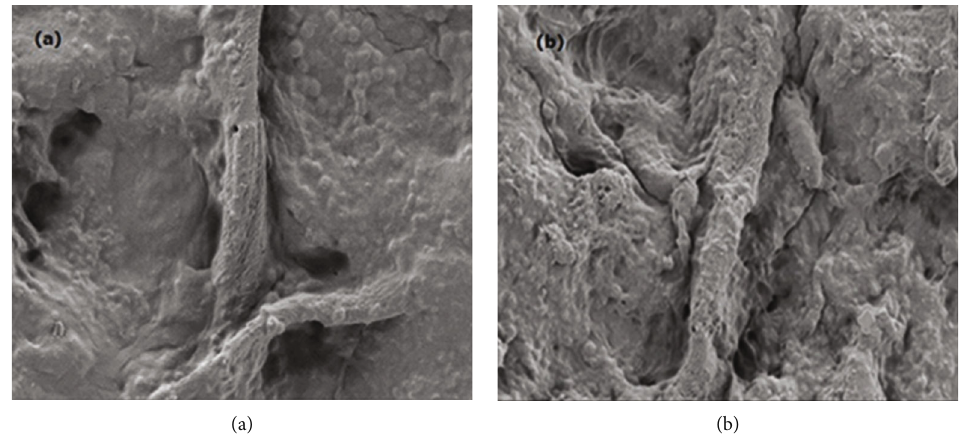
Figure 3: SEM image of the prepared CPCN composite fi lm (a) before and (b) after